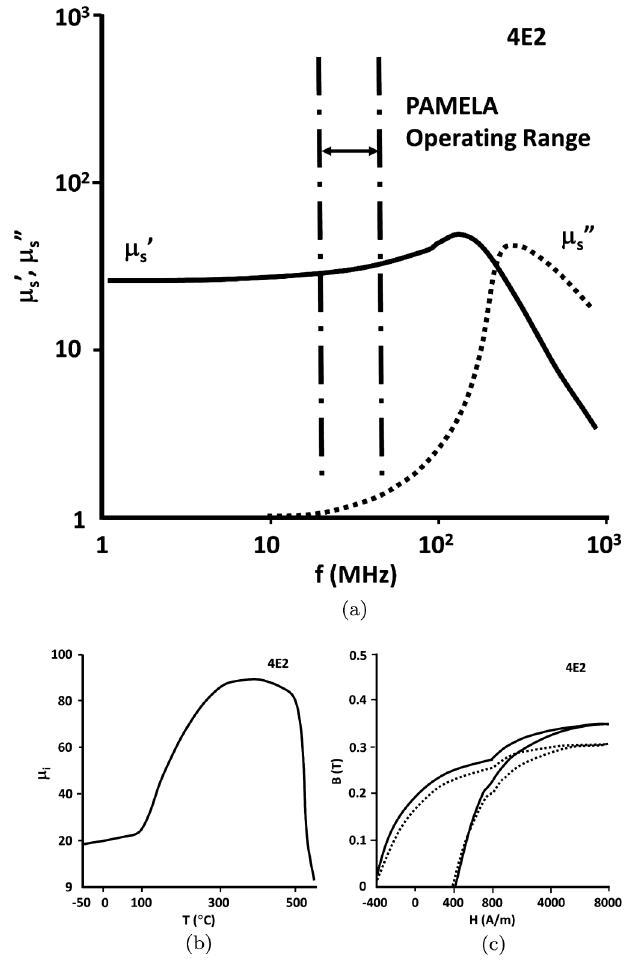
FIG. 24. Material properties of NiZn ferrite 4E2. (a) Frequency dependence of complex permeability. (b) Temperature depen- dence of imaginary part of permeability. (c) The magnetic flux density B as a function of the magnetic field strength H.